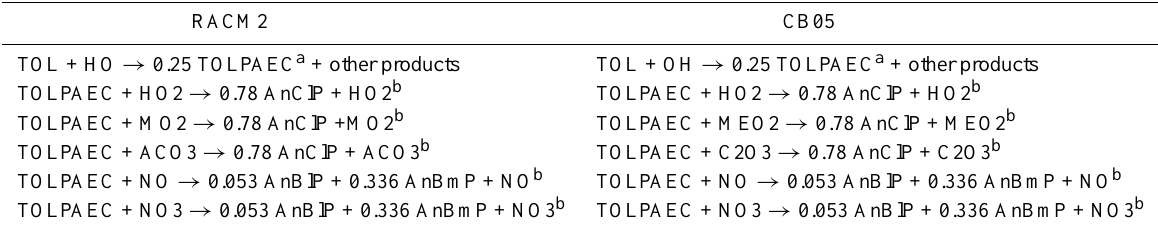
Table 3a. Toluene oxidation chemistry for SVOC formation. RACM2 CB05 TOL + HO → 0.25 TOLPAEC a + other products TOL + OH → 0.25 TOLPAEC a + other products TOLPAEC + HO2 → 0.78 AnClP + HO2 b